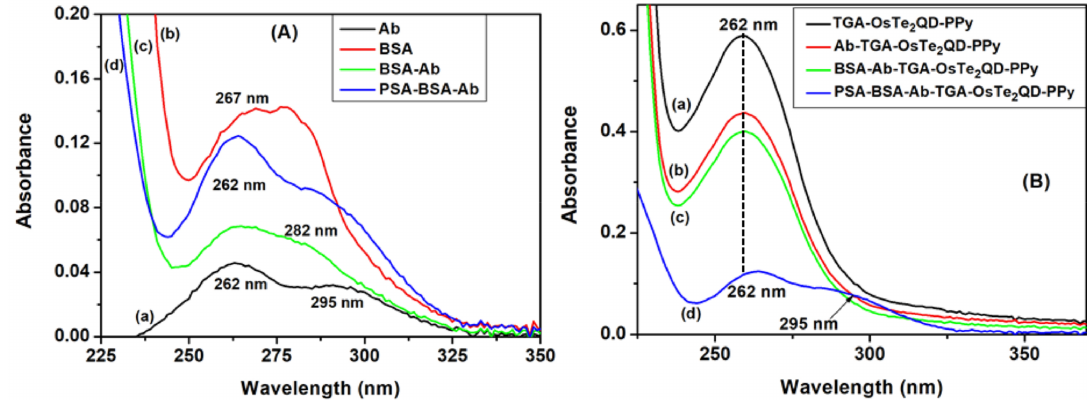
Figure 5. Optical signatures of ( A ): (a) Ab, (b) BSA, (c) BSA-Ab and (d) PSA-BSA-Ab. ( B ) UV-Vis spectrophotometer of (a) TGA-OsTe 2 QD-PPy, (b) Ab-TGA-OsTe 2 QD-PPy, (c) BSA-Ab-TGA-OsTe 2 QD-PPy and (d) PSA-BSA-Ab-TGA-OsTe 2 QD- PPy in 0.1 M PBS, pH 7.